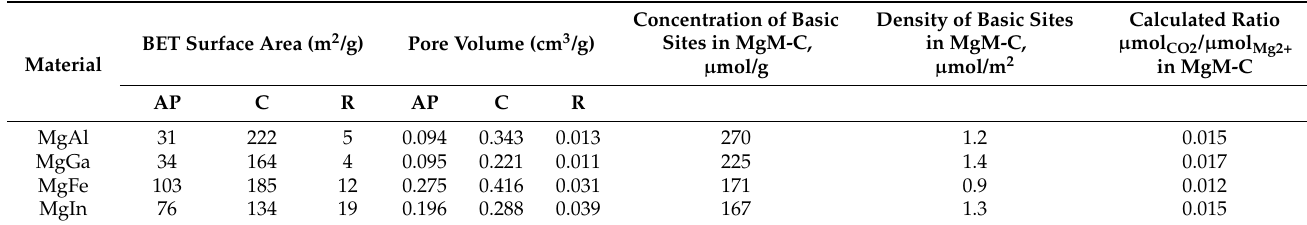
Table 3. BET surface of the as-prepared hydrotalcites (AP), derived mixed oxides (C), and rehydrated hydrotalcites (R), as well as the basic properties of MgM-C